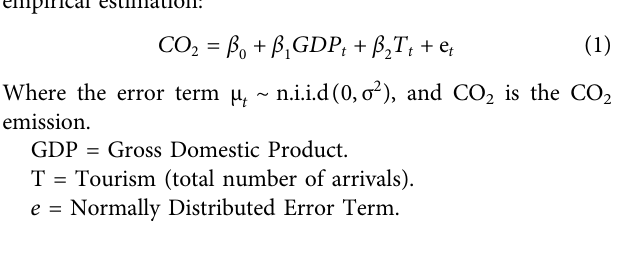
Frontiers in Environmental Science |